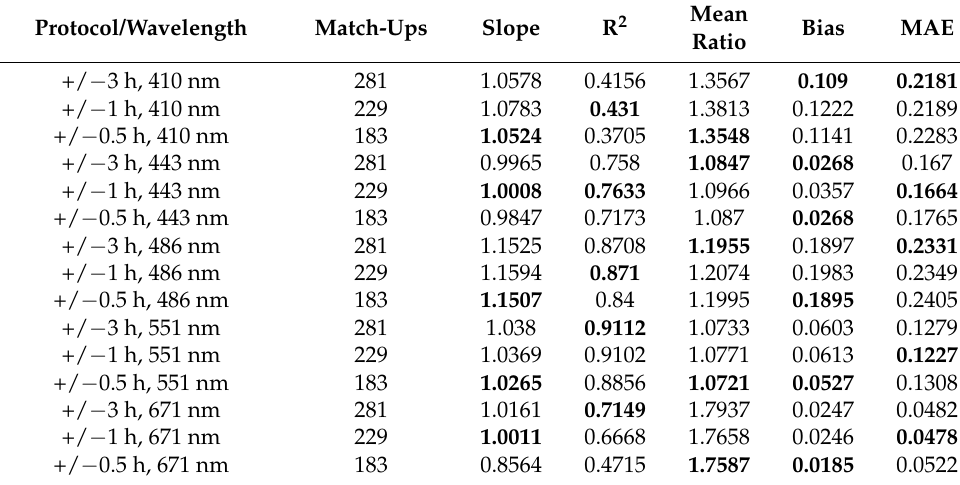
Table 4. Venise permissive protocol, June 2014 − May 2019. Center (in situ) pixel only, at +/ − 3, 1, and